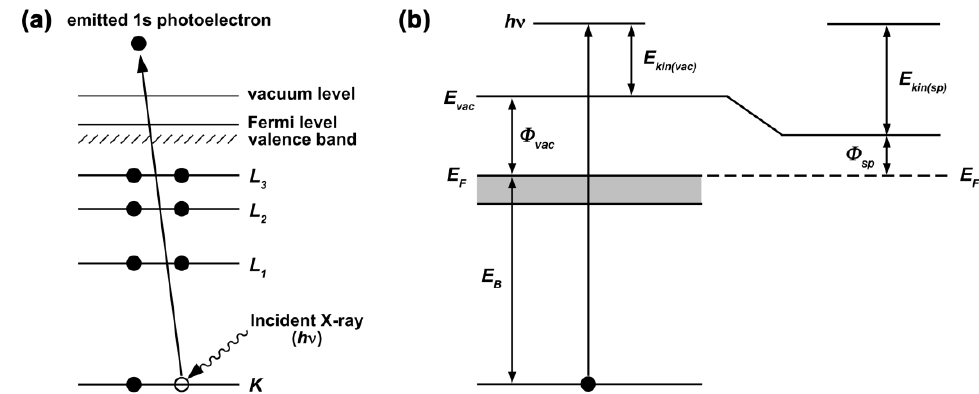
Figure 5. ( a ) The schematics of the photoemission process where a 1s photoelectron is ejected from the K core level of the atom upon irradiation with X-ray photons. The energy levels are labeled. ( b ) The energy level diagram for the photoemission process into vacuum and into the spectrometer. E F is the Fermi level, the highest filled states below E F are colored in grey, E vac is the vacuum level, h ν is the energy of the incident X-ray photon that is transferred to the photoelectron, E B is the binding energy of the photoelectron, Φ vac and Φ sp are the work functions relative to the vacuum level and the spectrometer level, respectively, E kin(vac) and E kin(sp) are the kinetic energies of the photoelectron in vacuum and measured by the spectrometer, respectively.